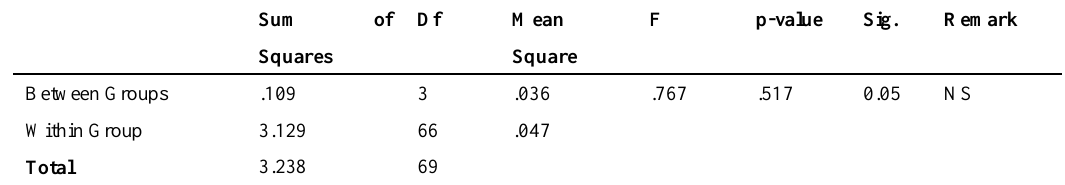
Table 7: Analysis of Variance (ANOVA) of grand mean responses of the respondents on major factors responsible for inflation in Nigeria based on their age